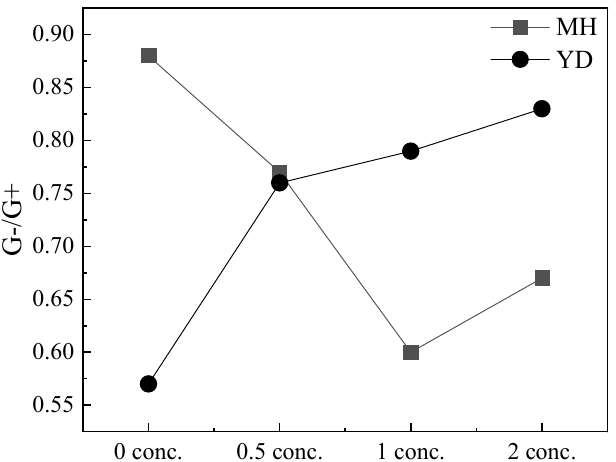
Figure 6. The ratio of Gram-negative to Gram-positive bacteria at jointing stage of